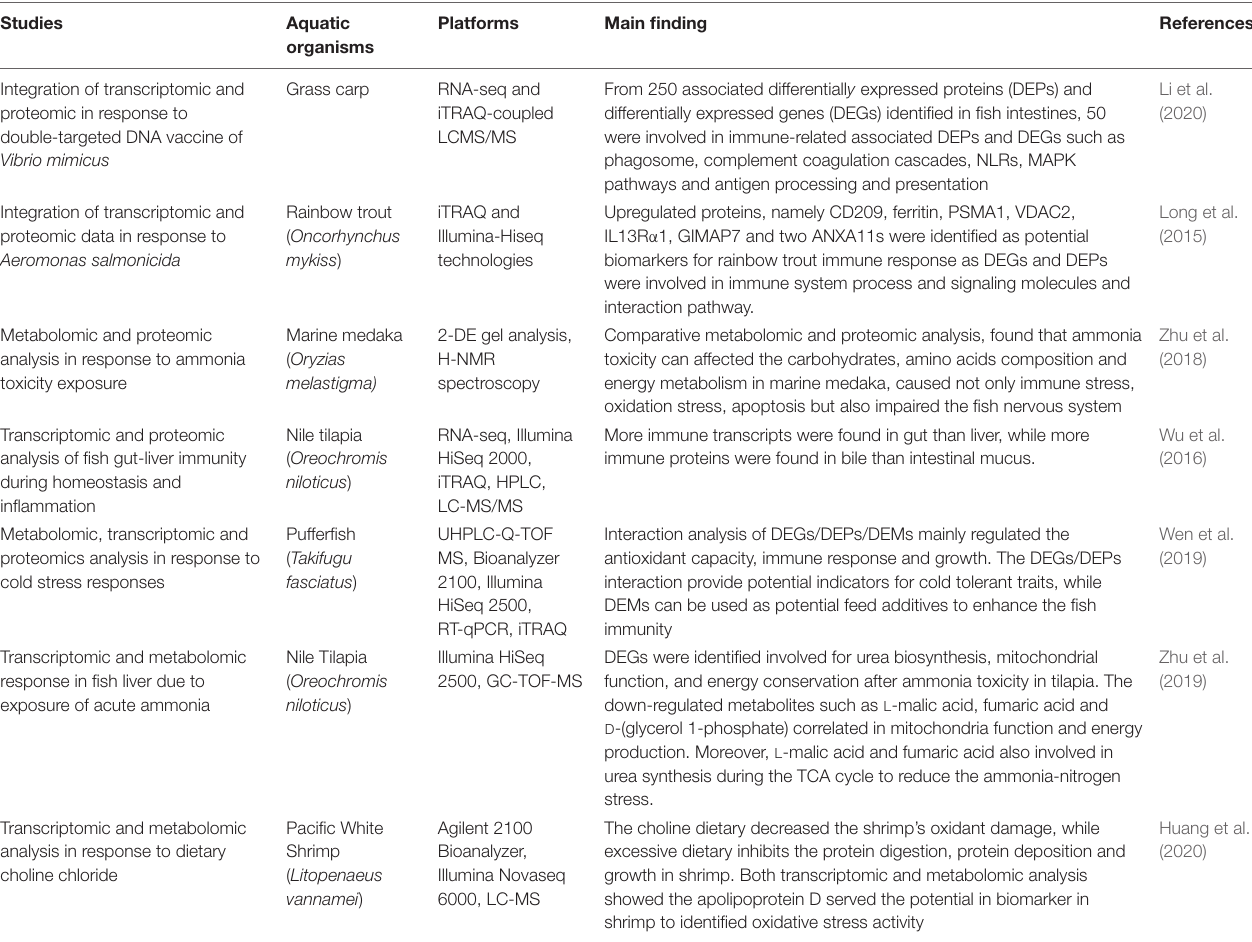
TABLE 5 | The Integration of omics approach on aquatic